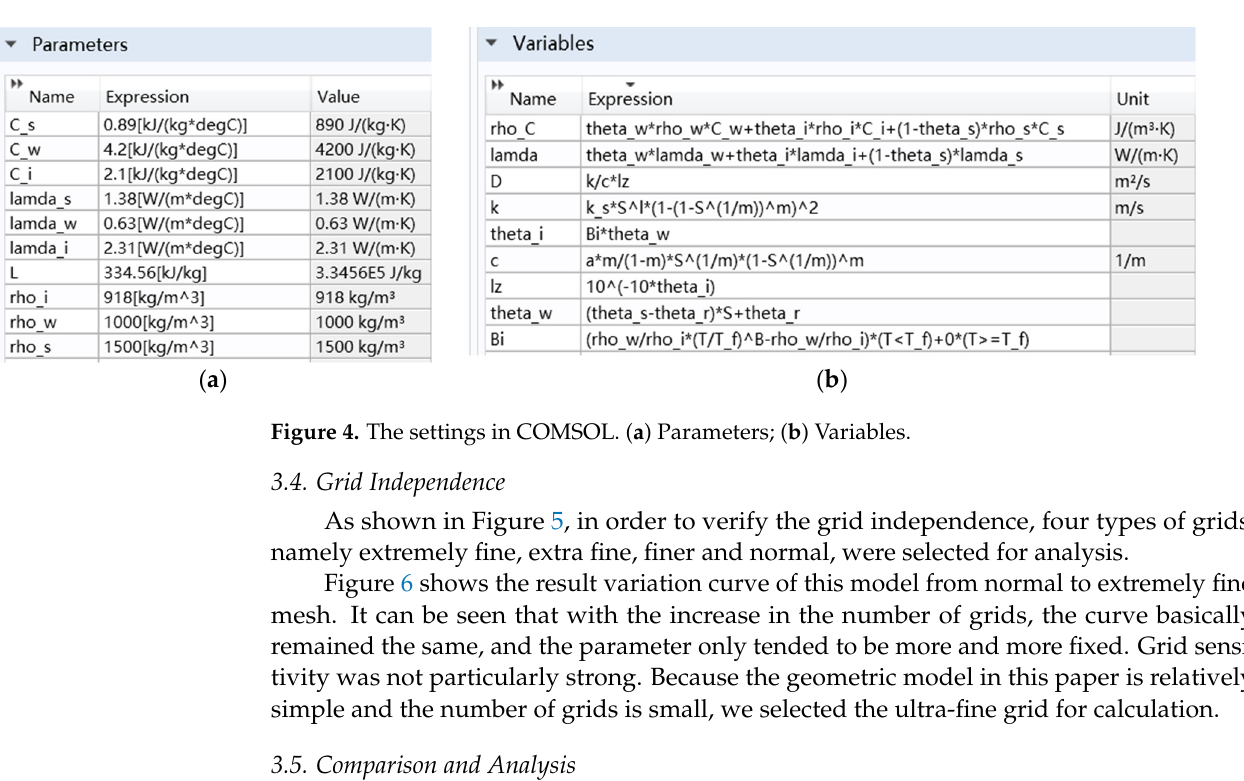
( d ) Figure 5. Grid. ( a ) Normal; ( b ) finer; ( c ) extra fine; ( d ) extremely fine.